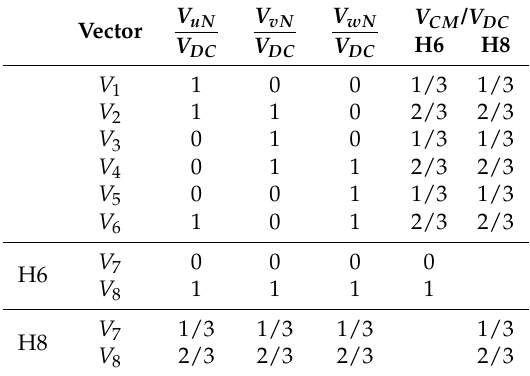
Table 2. Common-mode voltage ( V CM ) values.